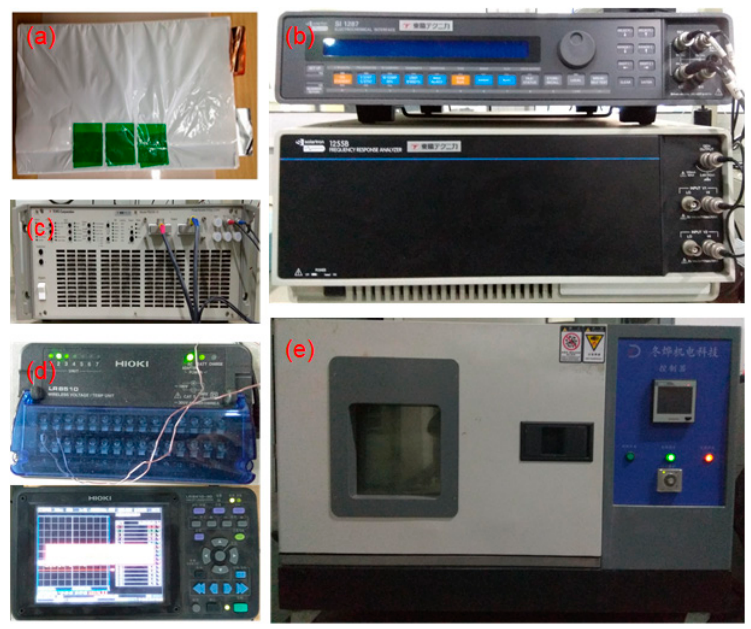
Figure 7. Experimental setup: ( a ) the battery cell; ( b ) the electrochemical workstation; ( c ) the power booster; ( d ) the temperature measurement station; ( e ) the environment chamber.